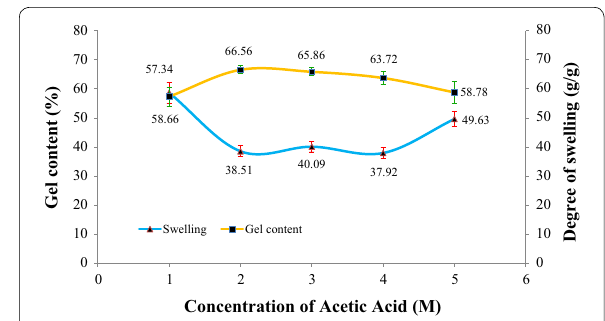
Fig. 3 Effect of CMSS concentration on gel content and degree of swelling of CMSS–acid hydrogel